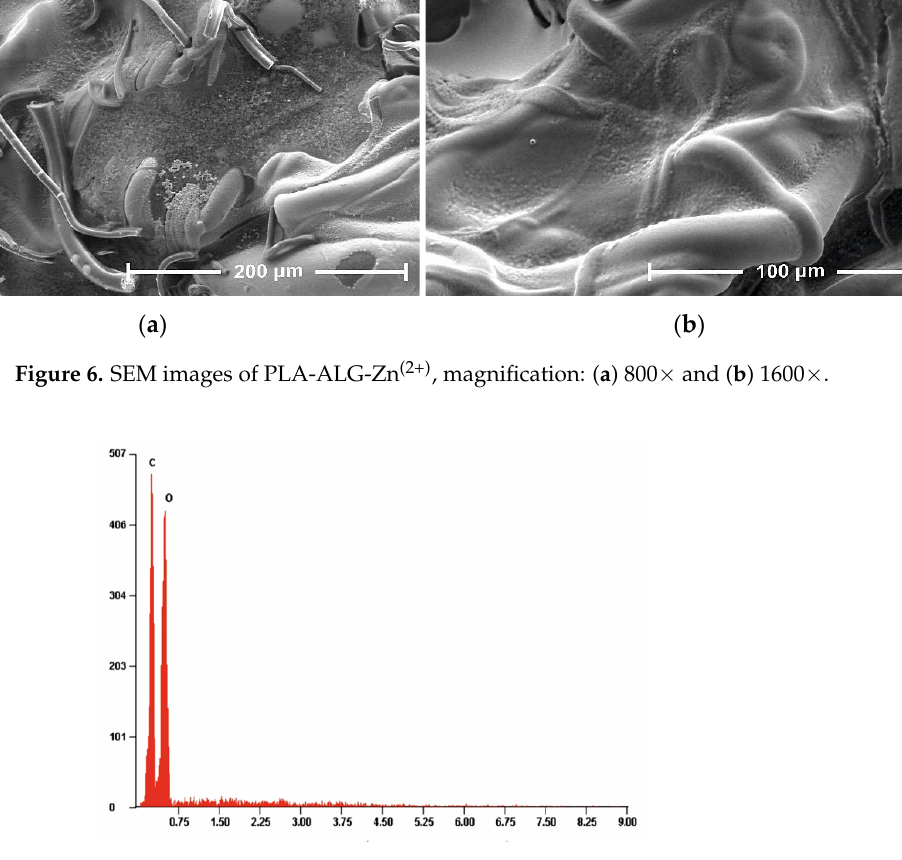
Figure 8. Example of the energy-dispersive X-ray spectroscopy (EDS) spectrum of PLA-ALG-Na (+) . Figure 9. Example of the energy-dispersive X-ray spectroscopy (EDS) spectrum of PLA-ALG- Zn (2+) .